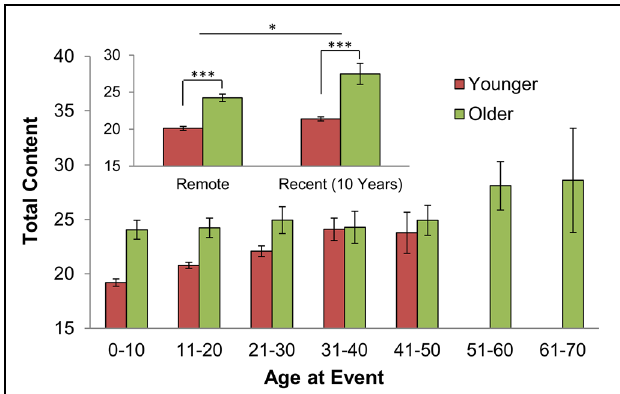
FIGURE 3 | Reported details from Remote and Recent AMs across age groups. Older individuals reported a greater number of total details from each decade of life (Younger subjects: 18–45 years old; older subjects: 46–78 years old; error bars: SEM). Inset: Recent AMs are those dated to within 10 years of the present; all remaining AMs are Remote ( ∗ p < 0.05; ∗∗∗ p < 0.001; see Table 2 for sample sizes within Remote and Recent intervals). Content declined with the age of the episode among all